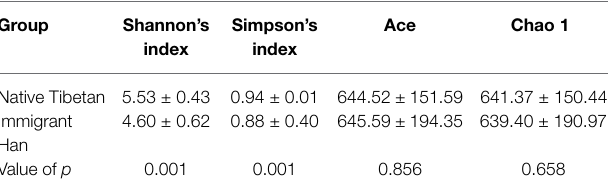
Values are means ± SD. Differences between the groups were analyzed with the Mann– Whitney U